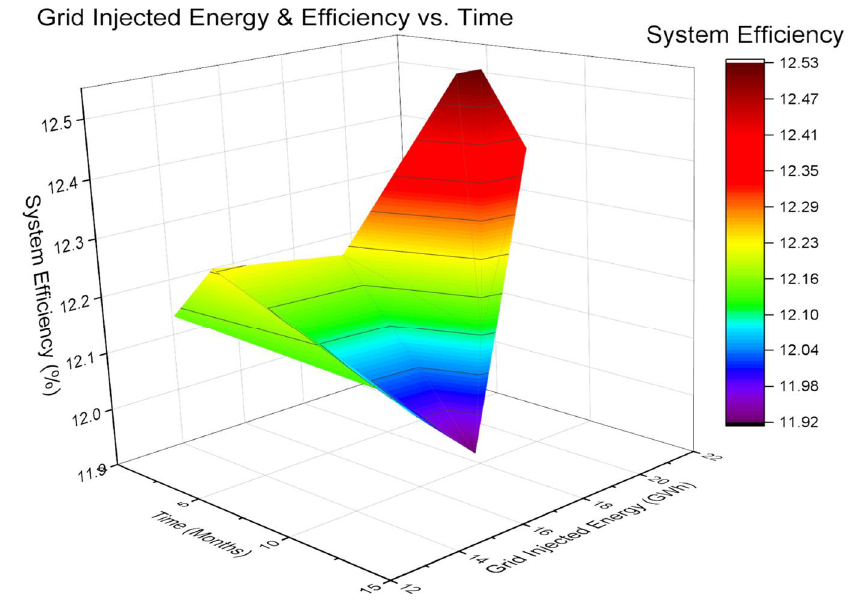
Figure 15. Figure showing FPV energy and efficiency vs. time